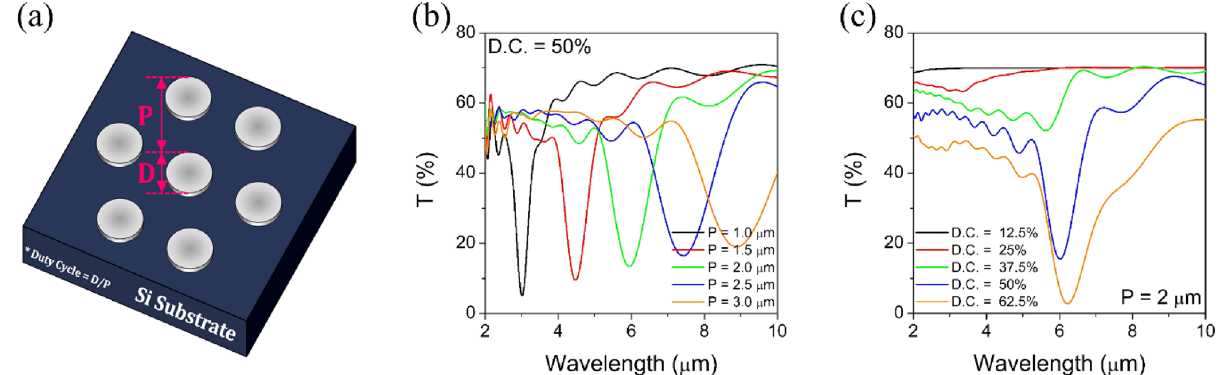
Figure 1. ( a ) Schematic diagram of a triangular lattice of metal nanodiscs and the simulated transmittance spectra as a function of ( b ) lattice period at a fixed duty cycle of 50% and ( c ) duty cycle at a fixed period of 2 μm. The thickness of Al nanodiscs is 50 Fig. 1b, the center wavelength of the stopband is linearly red-shifted from 3.05 to 8.91 μm as P increases from 1 to 3.0 μm at the intervals of 0.5 μm. Figure 1c shows the change in the transmission dip curve calculated with increasing D.C. from 0.125 to 0.625 at 0.125 intervals at the fixed grating period of 2 μm. When the D.C. is very small, it shows weak optical